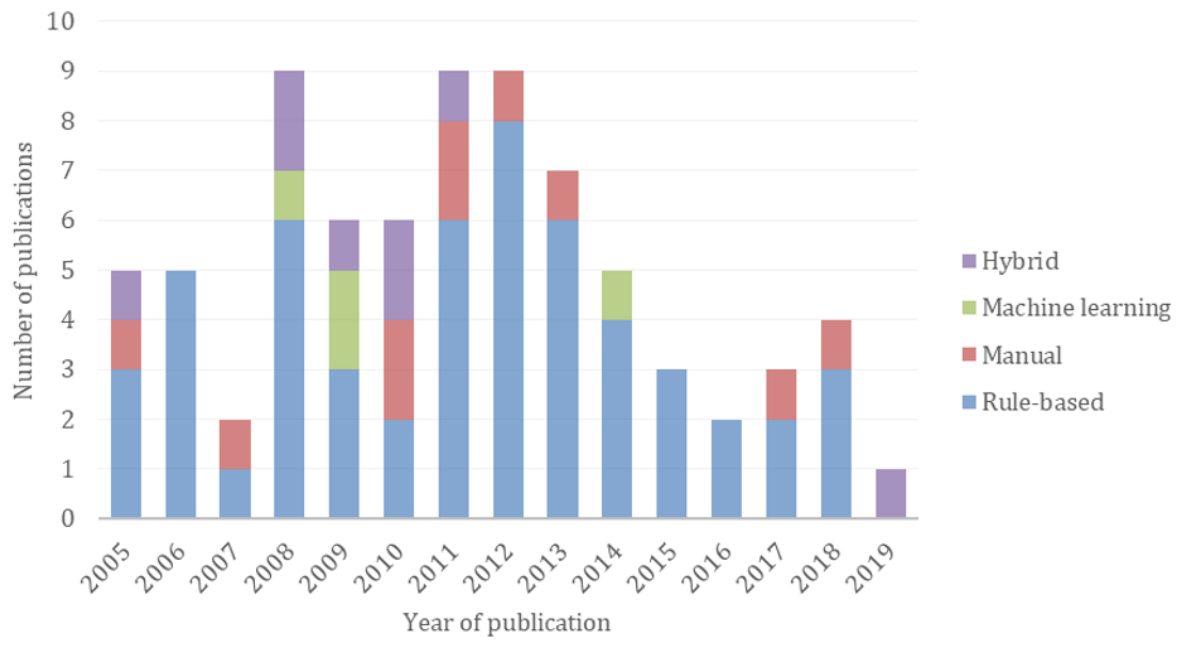
Figure 4. Number of articles applying a specific method for Systematized Nomenclature of Medicine Clinical Terms (SNOMED CT) mapping when available.